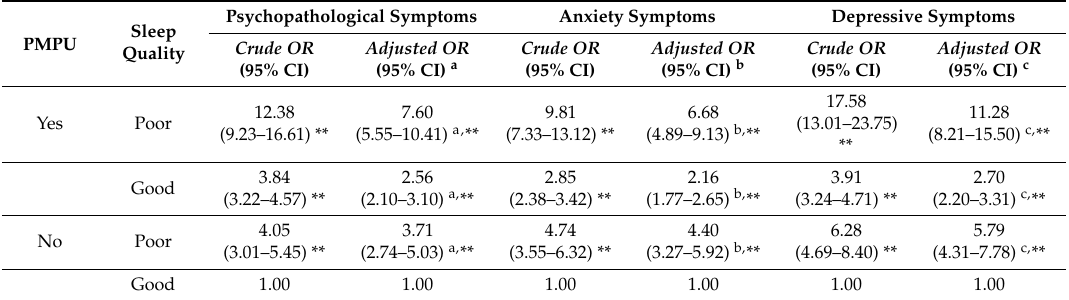
Table 3. Interactions of PMPU and sleep quality with mental